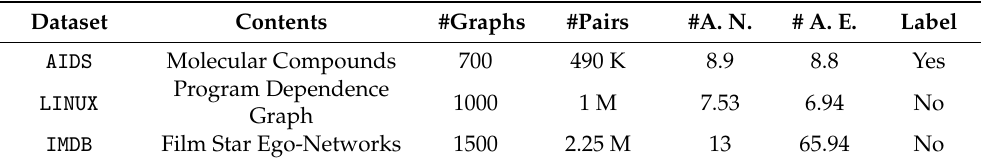
Table 2. Dataset statistics. # denotes the number of objects. A. N. and A. E. represent the average number of nodes and edges, respectively. Label denotes whether the graphs are